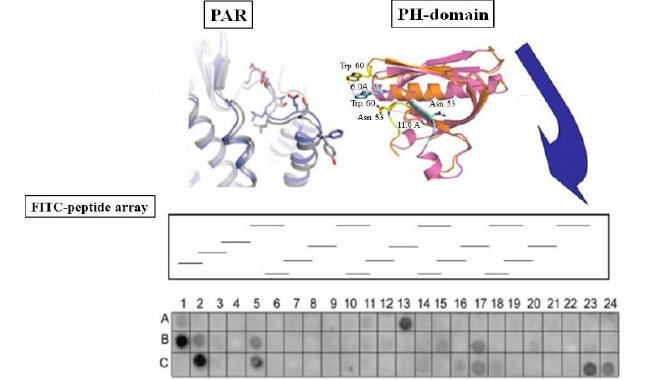
Scheme 1. A strategy depicting detection of GPCR PH-binding domain. Application of the purified Akt PH-domain onto an array membrane of cancer driver GPCRs. Scheme of blood vessel. GPCRs expressed in the endothelial cell lining, coagulation factors in the tumor microenvironment. GPCR mediated secretion of angiogenic factors.